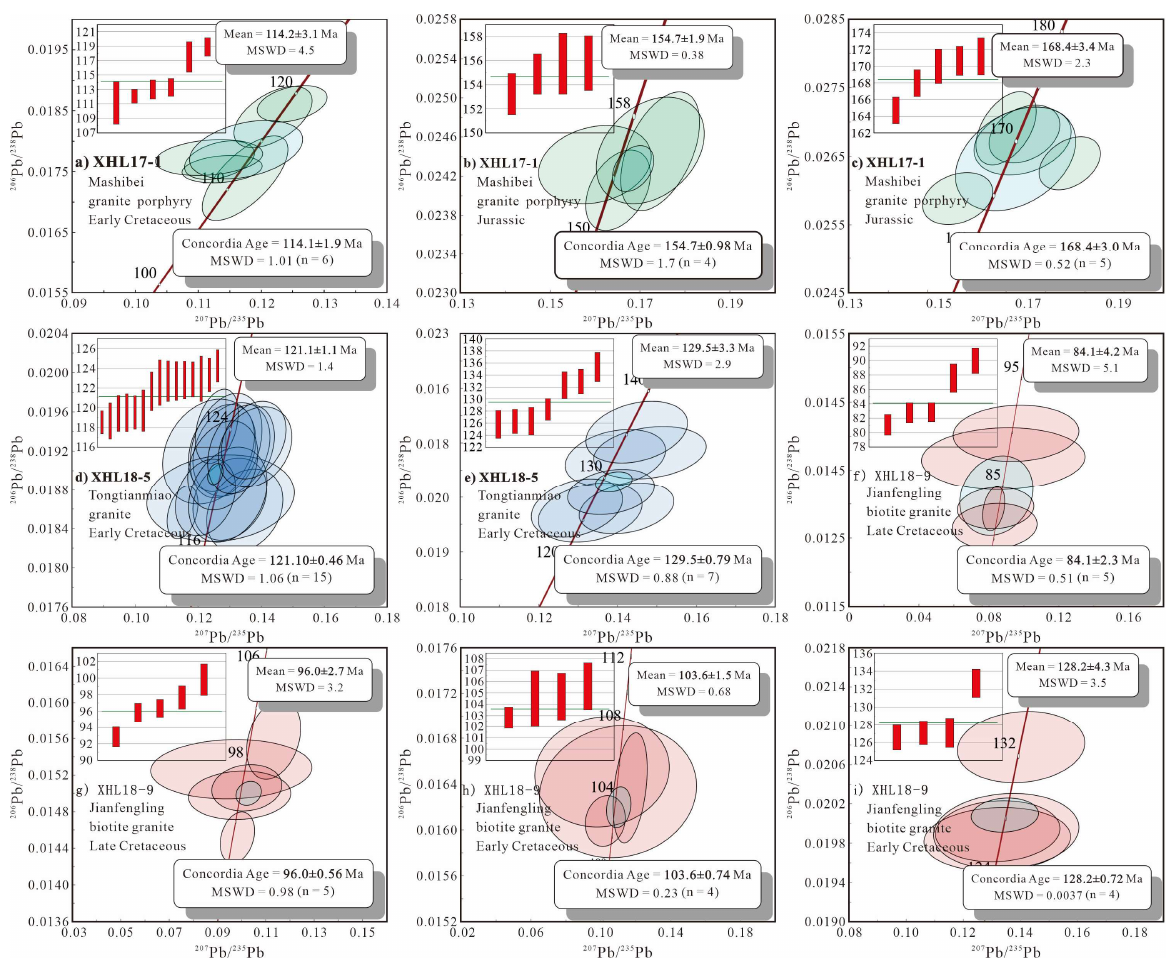
Figure 9. Zircon U−Pb concordant ages and mean ages. ( a – c ) the ages of sample XHL17-1; ( d , e ) the ages of sample XHL18-5; ( f – i ) the ages of sample XHL18-9. Zircons from the Tongtianmiao granite (Sample XHL18-5) yielded 206 Pb/ 238 U ages that can be divided into two Early Cretaceous age clusters: 119–123 Ma (n = 14) and 127–133 Ma (n = 5). Fifteen zircons have a concordant U-Pb age of 121.10 ± 0.46 Ma (MSWD = 1.06) (Figure 9d), and seven zircons give a concordant U-Pb age of 129.5 ± 0.79 Ma (MSWD = 0.88) (Figure